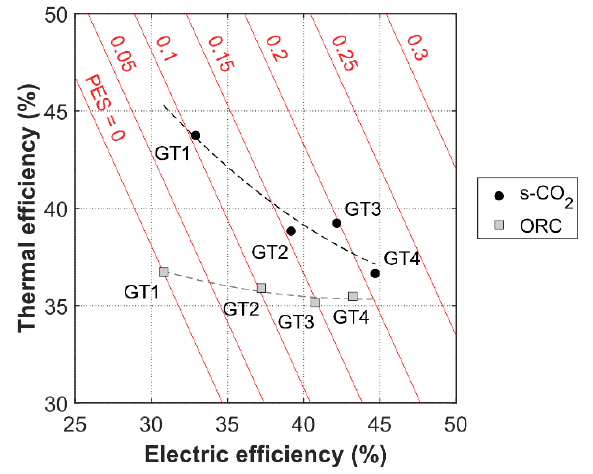
Figure 8. Plant design thermal end electric efficiency. Lines at constant PES values are traced in red.